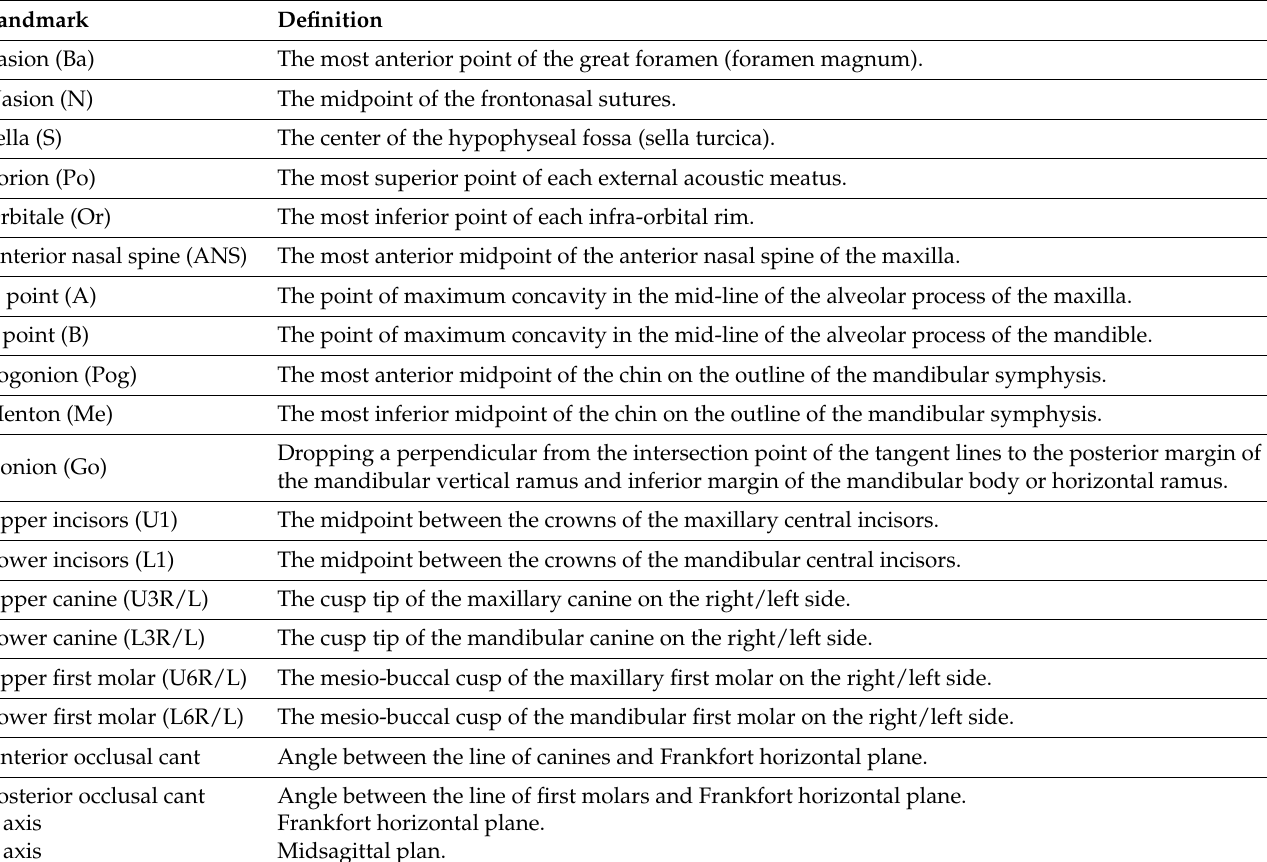
Table 1. Definition of the three-dimensional skeletal landmarks, angle and reference